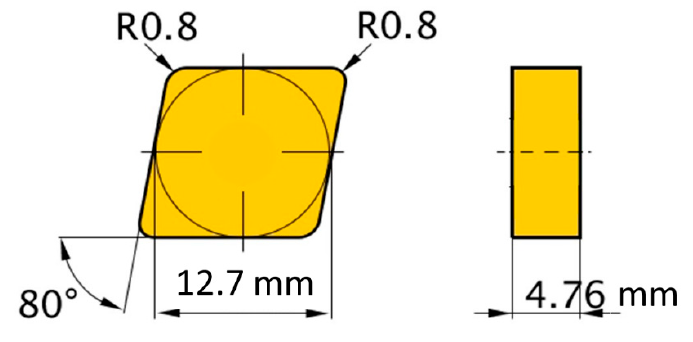
Figure 2. Sample Figure 2. Sample geometry.